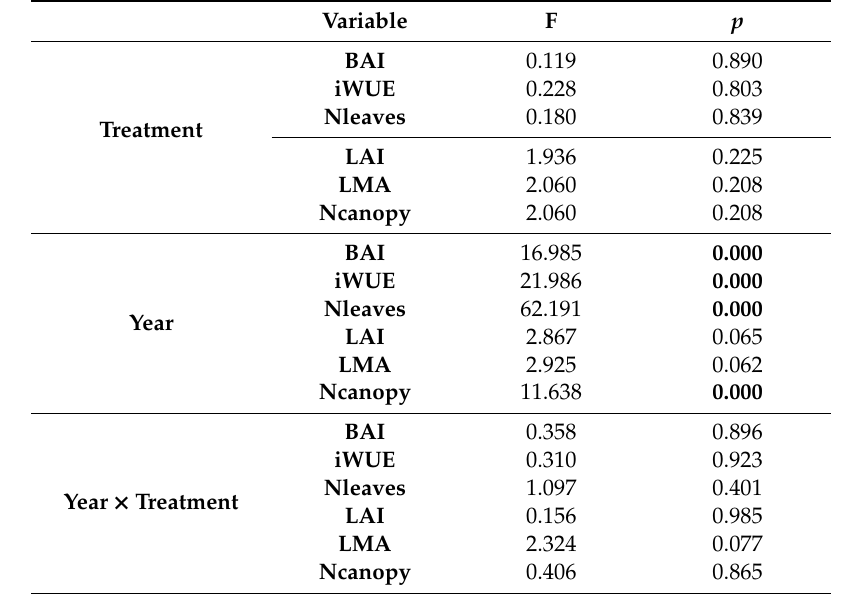
Table 2. Results for the general linear model (GLM) repeated measures, considering the treatment as between-subject factor and years as within-subject factor. The interaction between the two is also shown. Significant statistics ( p < 0.05) are highlighted in bold characters. Variables are: basal